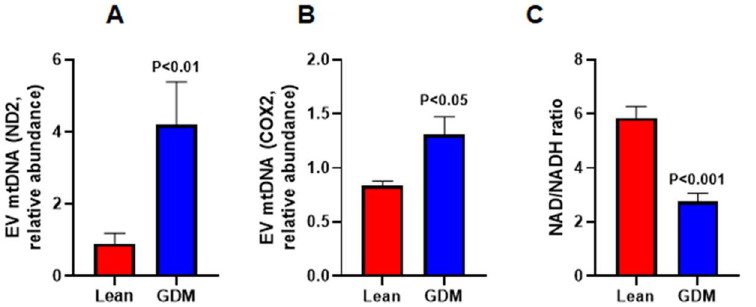
Figure 3. Levels of EV-associated mitochondrial DNA ( A , B ) as well as NAD/NADH ratio ( C ) in aortas from lean and GDM rats. n = 6–10.